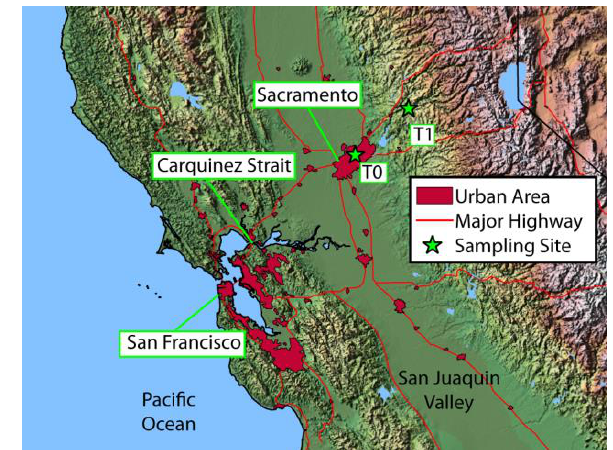
Fig. 1. Location of sampling sites and major urban areas. The urban site (T0) is located east of the Sacramento city center and the rural site (T1) is located in the Sierra Nevada foothills. The Carquinez Strait is a narrow passageway through which much of the airflow enters the Central Valley. Numerous oil refineries that emit SO 2 are located along the Carquinez Strait.